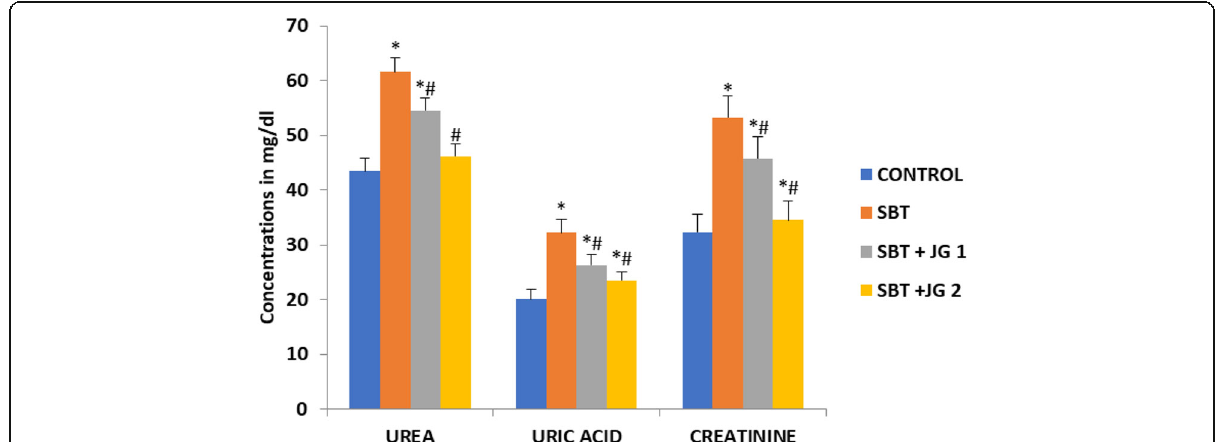
Fig. 1 The effect of methanolic leaf extract of Jatropha tanjorensis on sodium benzoate mediated alteration in serum renal metabolites in experimental rats. Data presented as Mean ± standard deviation ( n = 6). * Significantly different from normal control group at P < 0.05, # significantly different from group SBT at P < 0.05. Control: Animals were given distilled water only; SBT: Animals were treated with oral